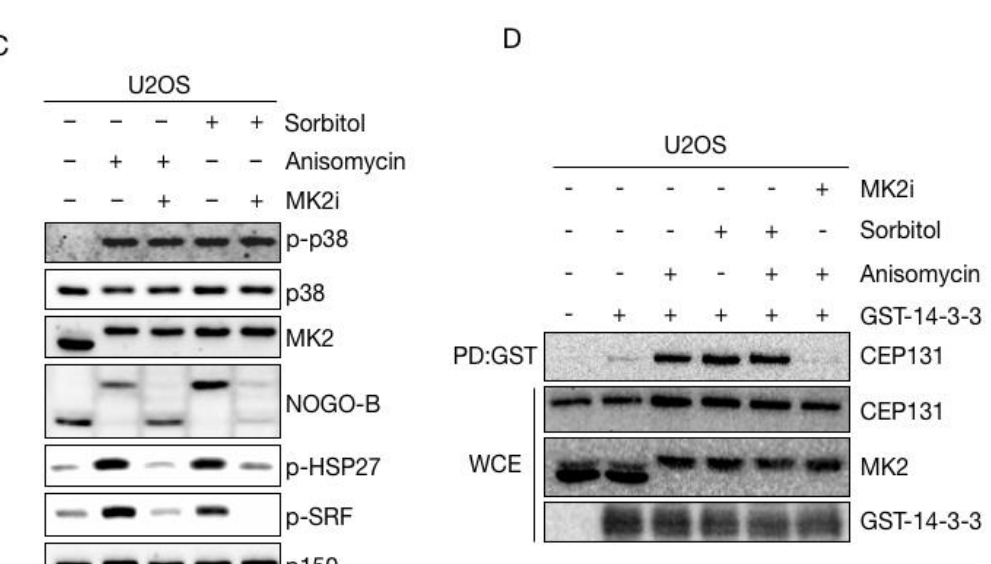
Figure 4. Sorbitol does not interfere with phosphorylation of MK2 targets. ( A ) U2OS cells were treated with anisomycin or sorbitol (1 h) in the indicated combinations. Cells were immunostained with antibodies against CEP131 and counterstained for nuclear content with DAPI. PCNT; Pericentrin. Scale bars, 10 µ m. ( B ) Quantification of ( A ). At least 100 cells were scored per condition in 3 independent experiments. Bars indicate the mean +/ − SEM. p -values were calculated from a one-way ANOVA using Dunnett’s correction for multiple testing. ****, p < 0.0001, n.s.; not significant. CS; centriolar satellites. ( C ) U2OS cells were pretreated with an MK2 inhibitor (MK2i—1 h) and incubated